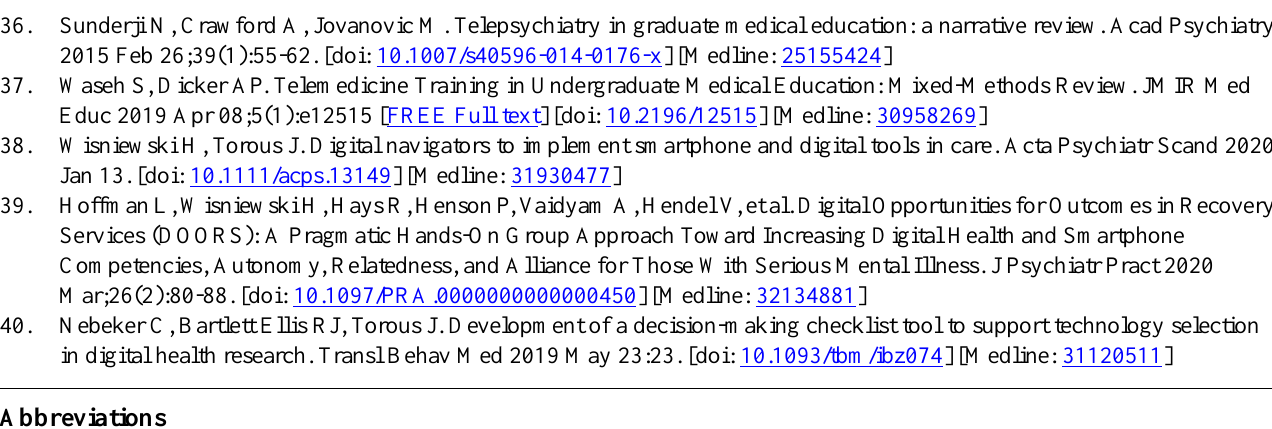
DOORS: Digital Opportunities for Outcomes in Recovery